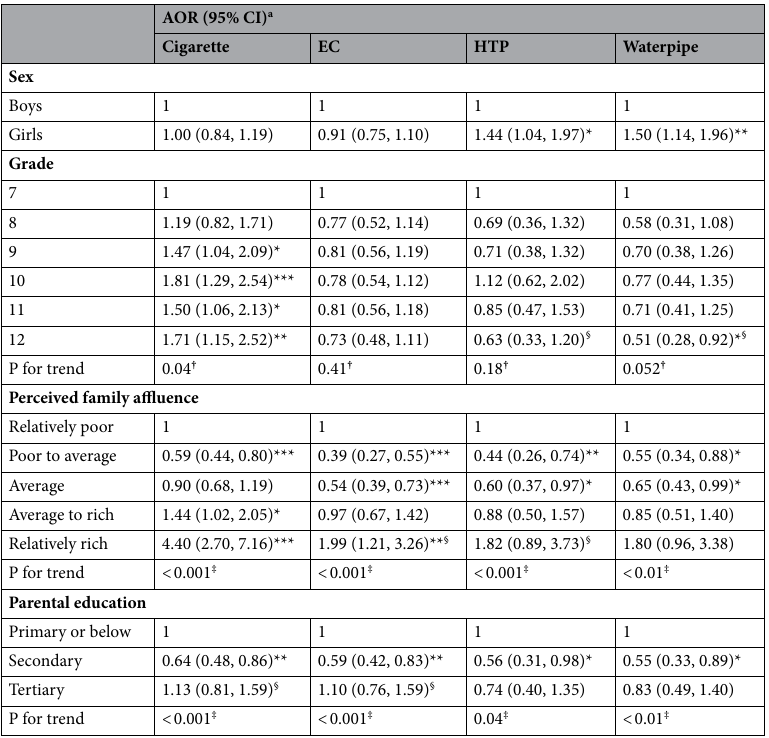
Table 4. Associations between sociodemographic factors and current (vs non-current) tobacco use in ever users. * P < 0.05, ** P < 0.01, *** P < 0.001. † Linear trend. ‡ Curvilinear (quadratic) trend. § Interaction with sex. EC, e-cigarette; HTP, heated tobacco product; AOR, adjusted odds ratio; CI, confidence interval. a Adjusted odds ratios adjusted for sex, grade, perceived family affluence, parental education, and school clustering